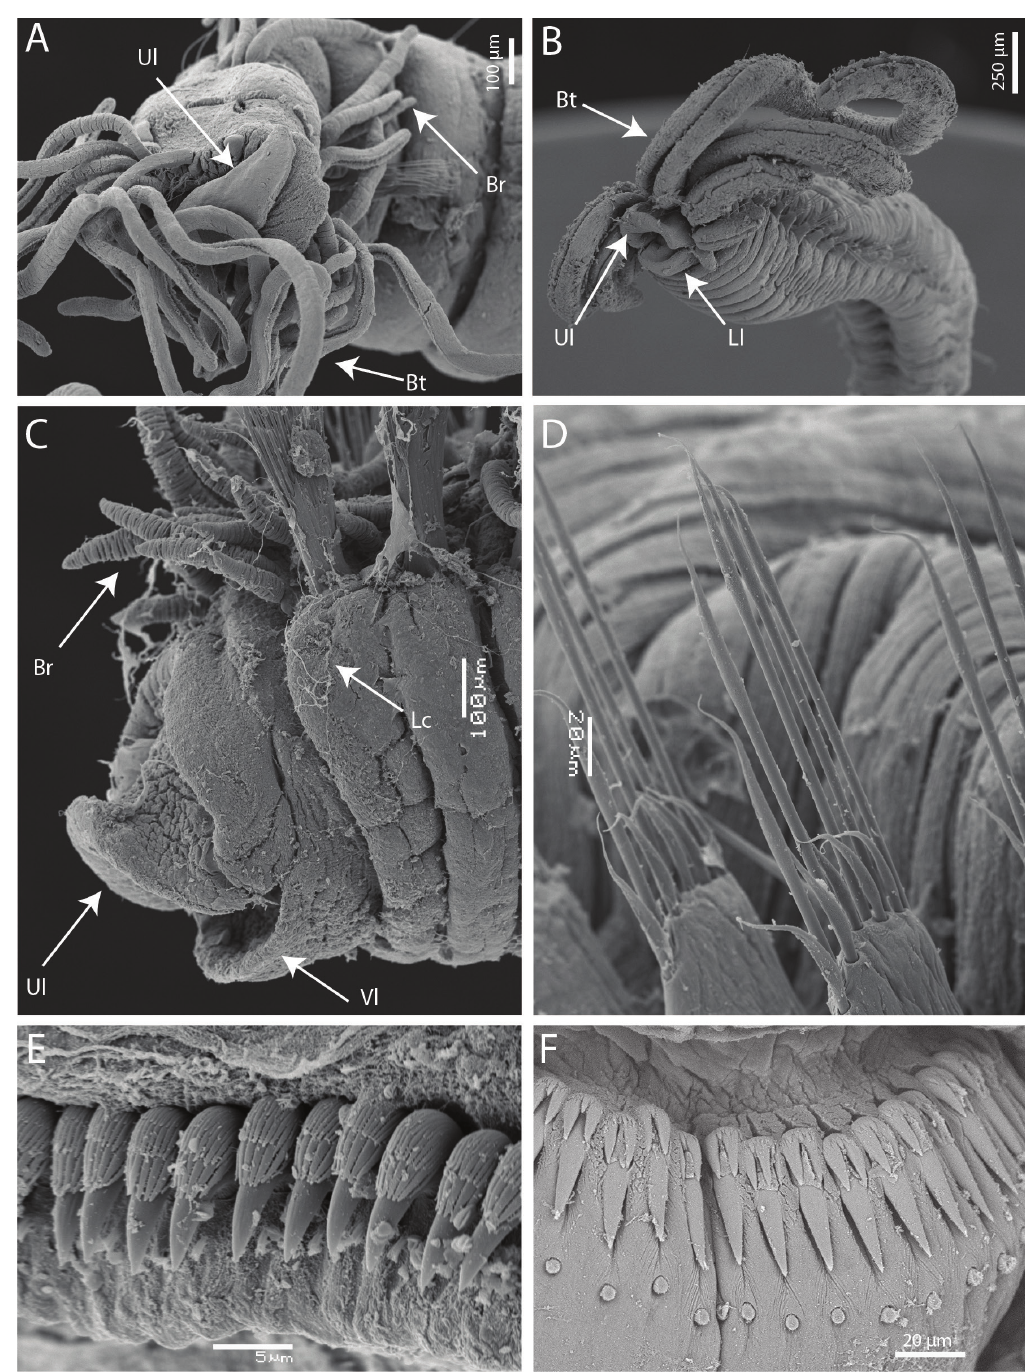
Fig. 4. Diversity of Telothelepodidae Nogueira, Fitzhugh & Hutchings, 2013 and Thelepodidae Hessle, 1917, SEM. A . Parathelepus collaris (Southern, 1914), anterior end, frontal view (AM W.53063). B . Thelepus corsicanus Lavesque, Londoño-Mesa, Daffe & Hutchings, 2020, anterior end, latero-frontal view (AM W.53069). C . Streblosoma cabiochi Lavesque, Londoño-Mesa, Daffe & Hutchings, 2020, anterior end, lateral view (AM W.53066). D . Thelepus corsicanus , thoracic notochaetae (AM W.53069). E . Parathelepus collaris , abdominal uncini, (AM W.53063). F . Thelepus japonicus Marenzeller, 1884, abdominal uncini, SG48. (SMA-NL-Thele08). Abbreviations: Br = Branchiae; Bt = Buccal tentacles; Lc = lateral crest; Ll = Lower lip; Vl = Ventral lobe of SG